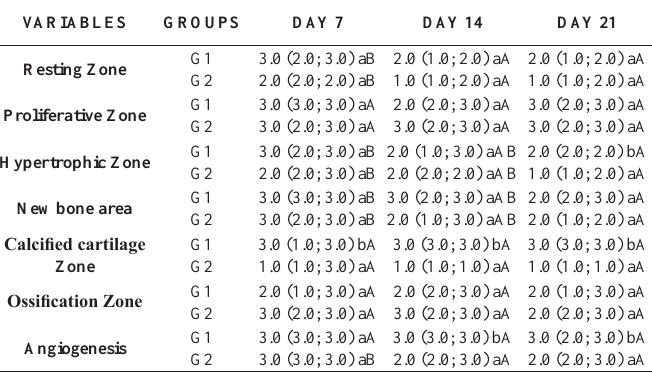
TABLE 3 – Median (minimum and maximum) values of the variables, according to groups (G1: irradiated, G2: control) and evaluation